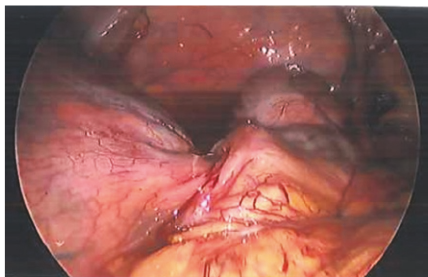
Figure 1: Laparoscopic view of fibroid (right) and its attachment to the bowel (left). Area of torsion noted in between.